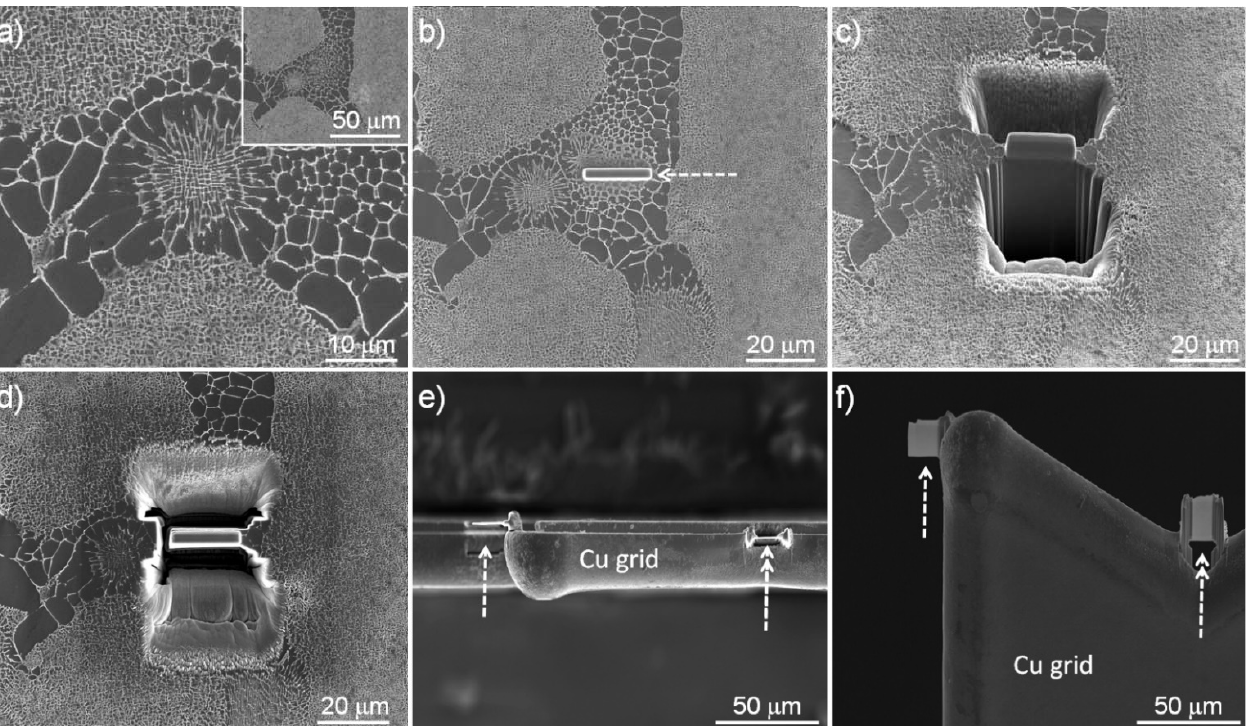
Figure 2. A series of a FIB lift-out technique for TEM sample preparation: ( a ) a plain view of an interdendritic region to be processed with an insert acquired at a low magnification; ( b ) a plain view showing platinum deposition on a small area of 20 × 4.5 µ m 2 marked with an arrow; ( c , d ) a typical milling process with a tilting view of gradual trenches near the platinum-deposited area; ( c ) a plain view of the area prior to cutting the remaining right side; the lamella was then lifted out and placed on a copper grid by a typical FIB lifting-out process; ( e ) two different lamellae on the same copper grid; and ( f ) a tilting view of the two lamellae prior to final thinning and cleaning. Note that in ( e ) and ( f ), two different lamellae were made from a dendrite core marked with a double arrow and an interdendritic region with an arrow, respectively. In panel ( f ), electron transparent areas show relatively brighter contrast.